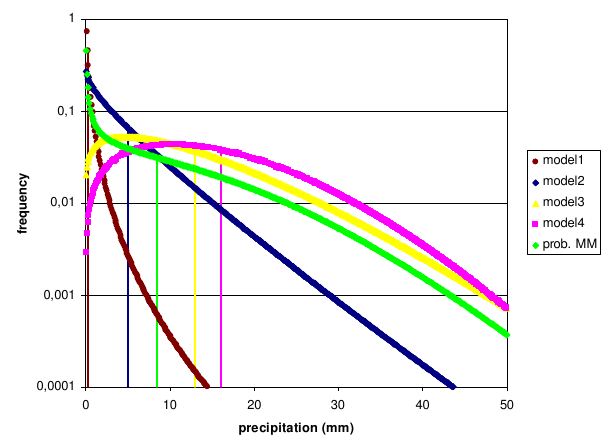
Fig. 4 : scheme of the probabilistic Multimodel SuperEnsemble Dressing technique, example for a Fig. 4. Scheme of the probabilistic multimodel superensemble given day: Probability Density Function of observed data conditioned to different models and dressing technique, example for a given day: probability density forecast values, together with the final Probability Density Function evaluated with Multimodel. function of observed data conditioned to different models and fore- cast values, together with the final probability density function eval- uated with